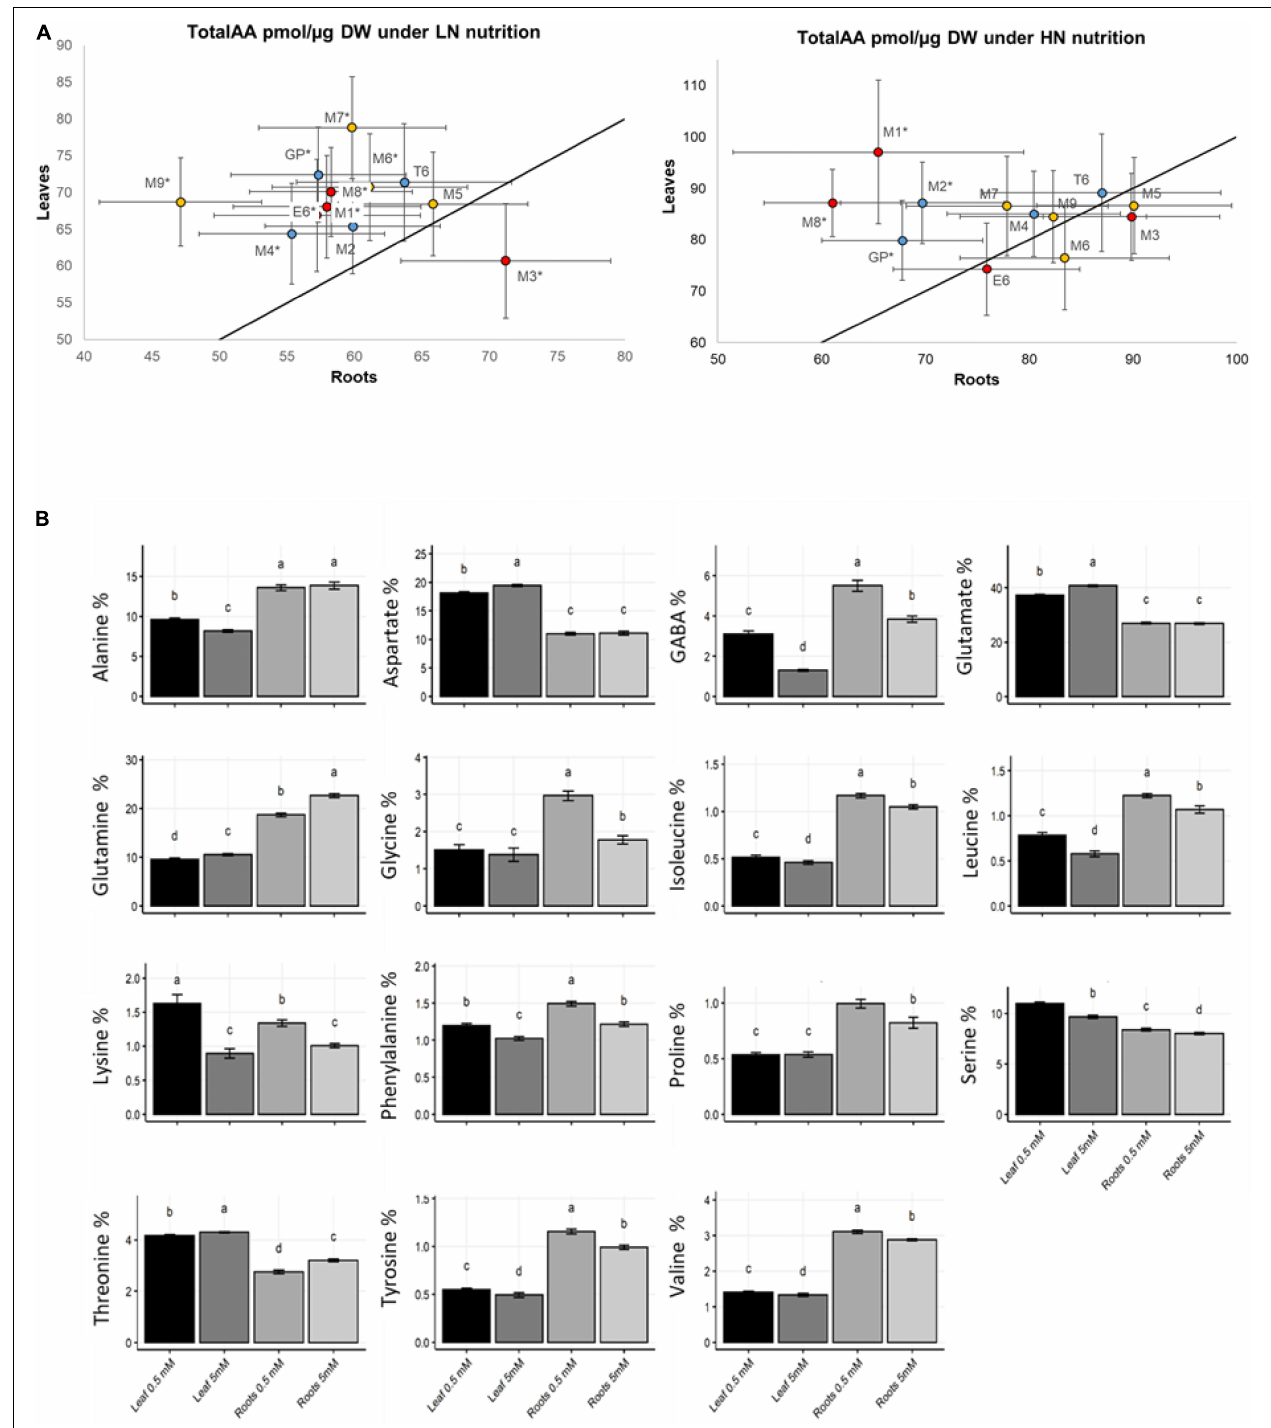
FIGURE 3 | Amino acid distribution in barley leaves and roots under LN and HN. Plants were grown for 14 days under LN or HN then leaves and roots were harvested separately and frozen under liquid nitrogen. Following freezing in liquid nitrogen, AA were quantified by HPLC as indicated in the “Material and Methods.” (A) Comparison of total amino acids levels in leaves were plotted against levels in roots of barley genotypes under LN and HN as indicated. The strait line represents the Y = X curve. Bars represent SE. Stars indicate a significant difference between LN and HN for each barley genotype (Student’s test, 13 ≤ n ≤ 16, p < 0.05). Colors of the dots correspond to the classes defined in Figure 1 . (B) Individual amino acid % in the barley collection under LN or HN. Four independent experiments were performed. Stars indicate significant difference between LN and HN (Student’s test, 13 ≤ n ≤ 16, p < 0.05). Bars represent SE.